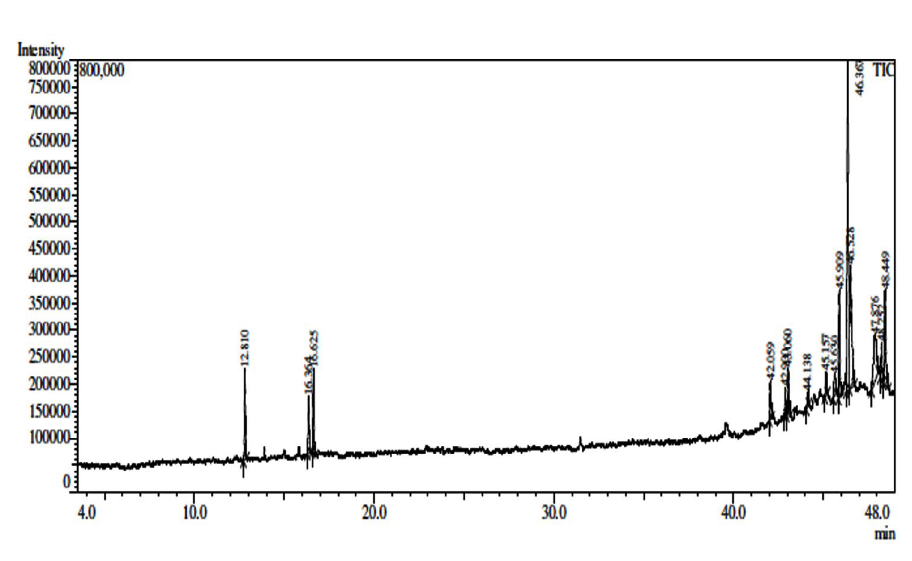
Fig. 4. GC chromatogram of purified polysaccharide.